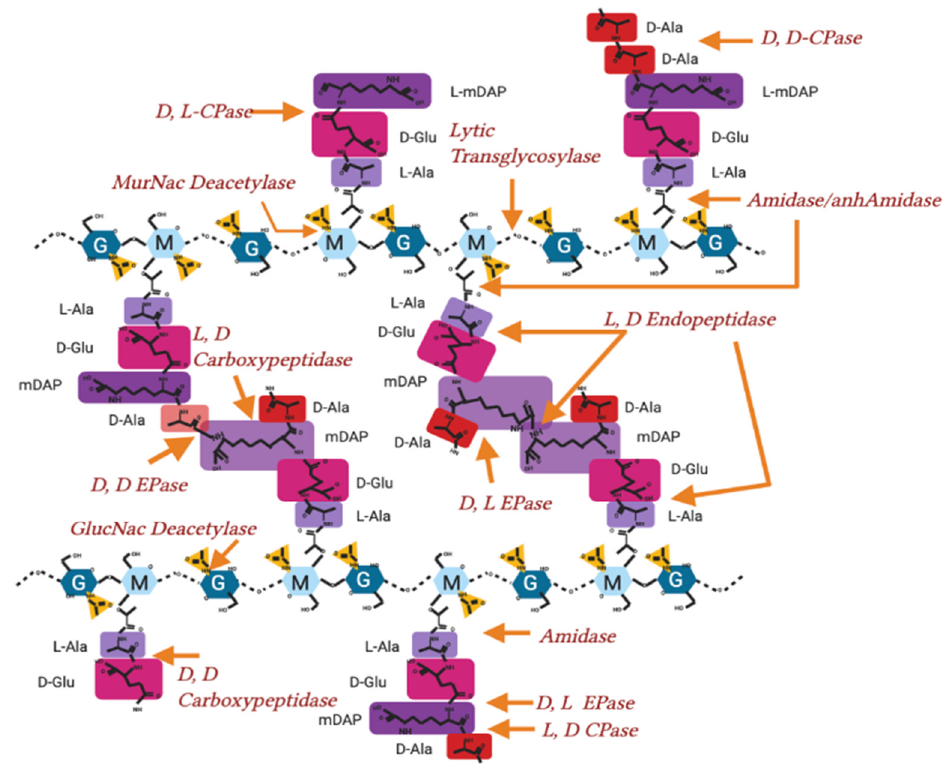
Figure A1. Hydrolase activity on peptidoglycan in Gram-negative bacteria. Peptidoglycan molecular structure, with sites of hydrolysis and enzyme nomenclature labelled. EPase-Endopeptidase, CPase-Carboxypeptidase.